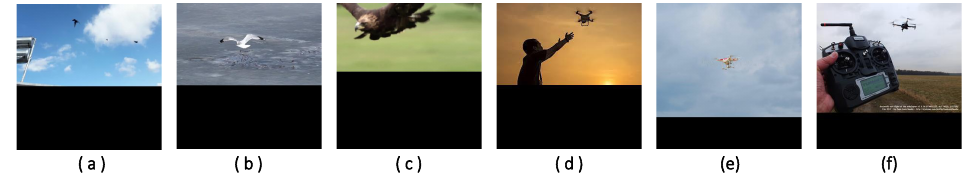
Figure 5. Some examples of real bird and RW-UAV images. ( a – c ) Bird images; ( d – f ) RW-UAV images. The size of the real images collected were between 227 × 227 pixels and 1280 × 1280 pix- els. Image sizes were scaled and converted to 224 × 224 pixels for the trained AI to make prediction. At the end of the resizing, a dataset with RW-UAV and bird image fragment size between 8 × 8 pixels and 95 × 95 pixels within a 224 × 224 pixel image was